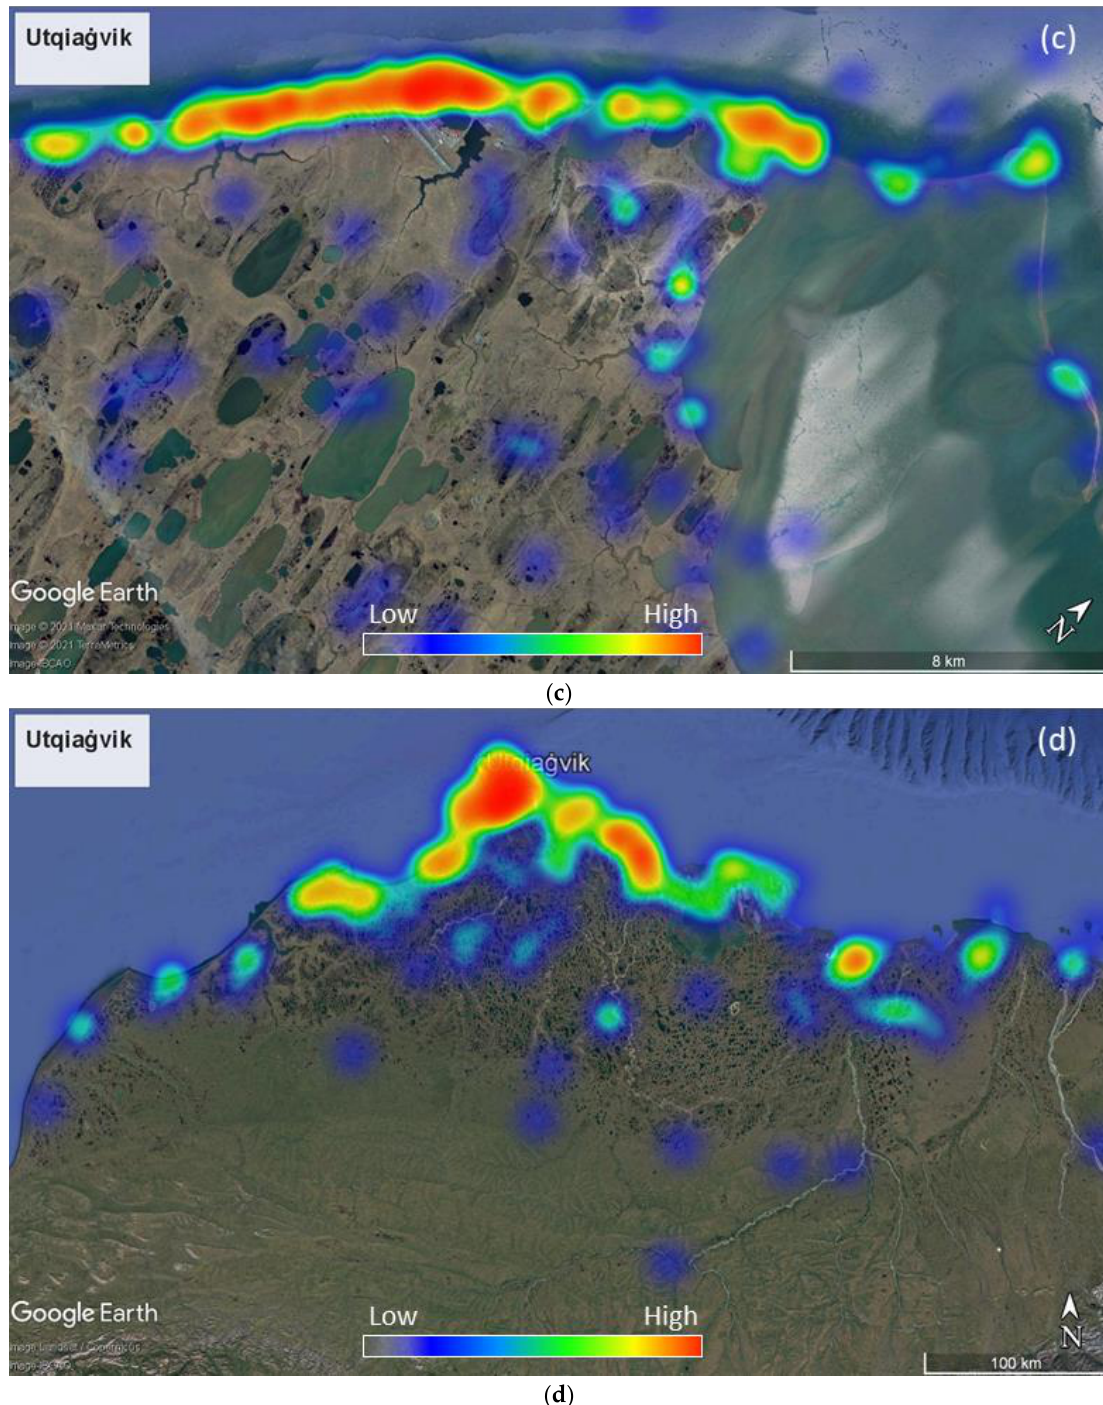
Figure 11. Heatmaps of permafrost degradation and coastal erosion in Utqiaġvik: ( a ) 2 km (southern and central section), ( b ) 2 km (northern section), ( c ) 8 km, and ( d ) 100 km.